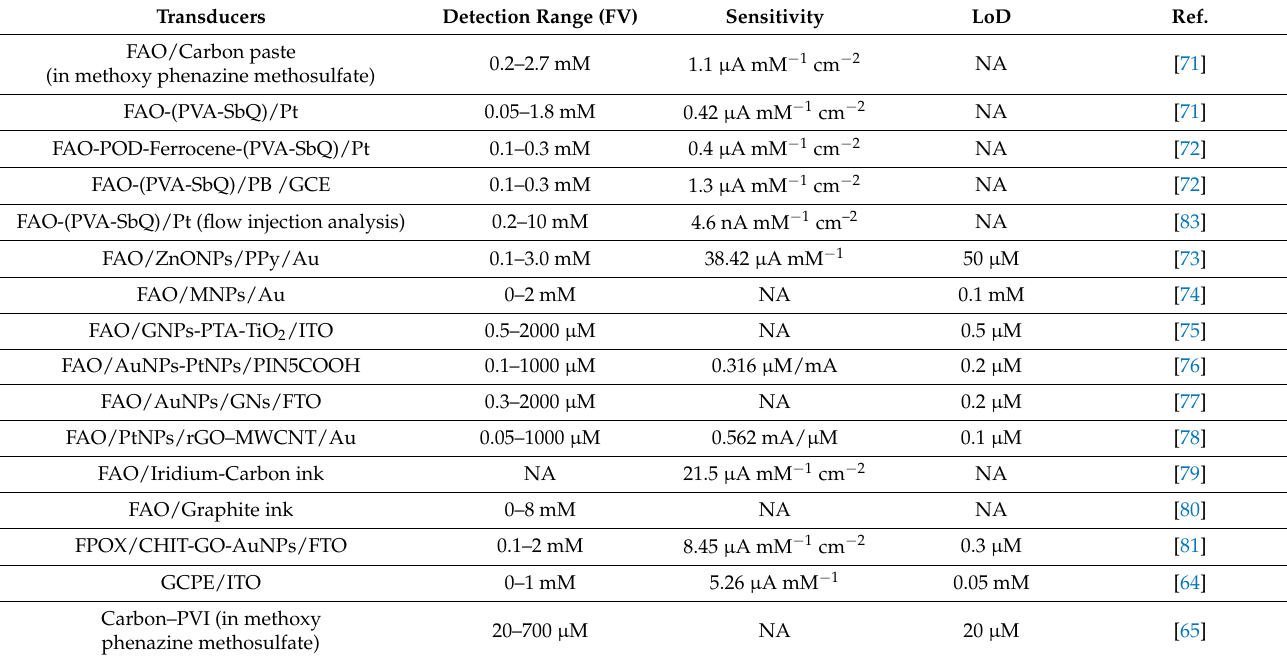
Table 3. Amperometric biosensors for detecting HbA1c based on